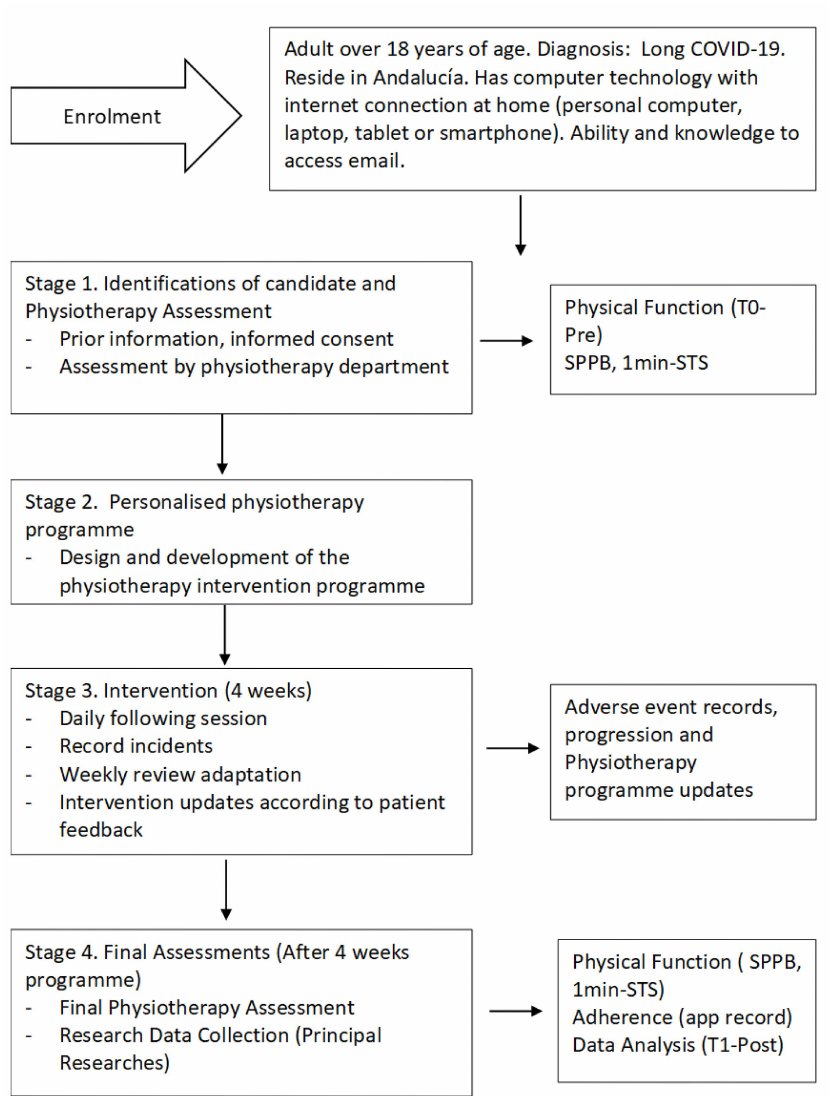
Figure 1. Flow diagram study